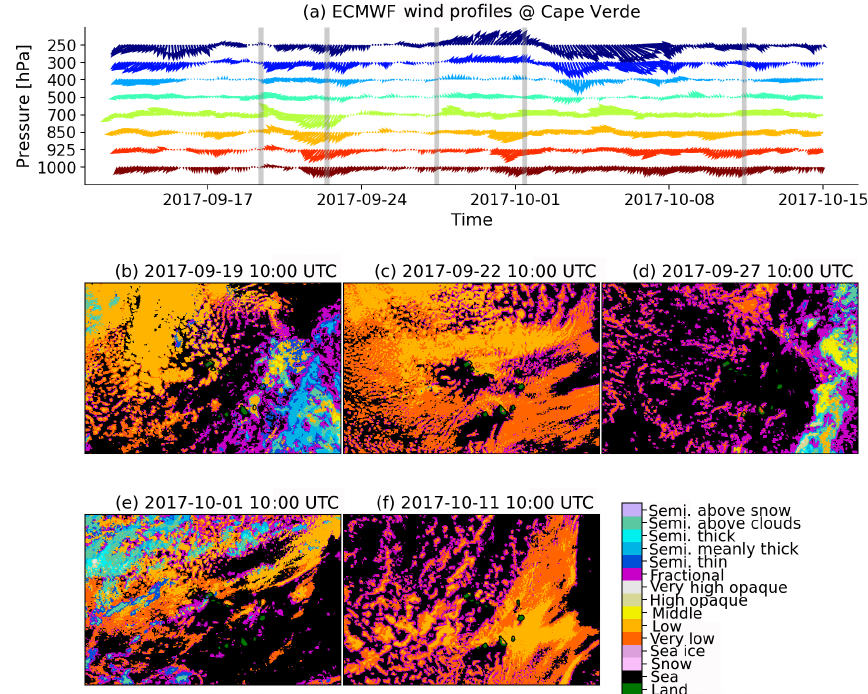
Figure 6. (a) ECMWF wind forecasts and (b–f) cloud scenery derived from Meteosat SEVIRI observations for the Cape Verde islands region using a state-of-the-art cloud classification algorithm (the cloud retrieval software of the Satellite Application Facility, with support for Now- casting and Very Short-Range Forecasting version 2016. (a) Average horizontal winds have been derived from a 2 . 5 × 2 . 5 ◦ (250km × 25km) domain centered on the Cape Verde islands and are plotted for each pressure level from 1000 to 250hPa against time using arrows. The arrow colors refer to the pressure level. Gray vertical lines mark the times of the subsequently shown cloud scenes. (b–f) Different cloud scenes observed with Meteosat SEVIRI for a domain of size 1500km × 1000km centered on the Cape Verde islands. The shadings refer to different cloud types derived with the cloud classification algorithm of the NWC-SAF